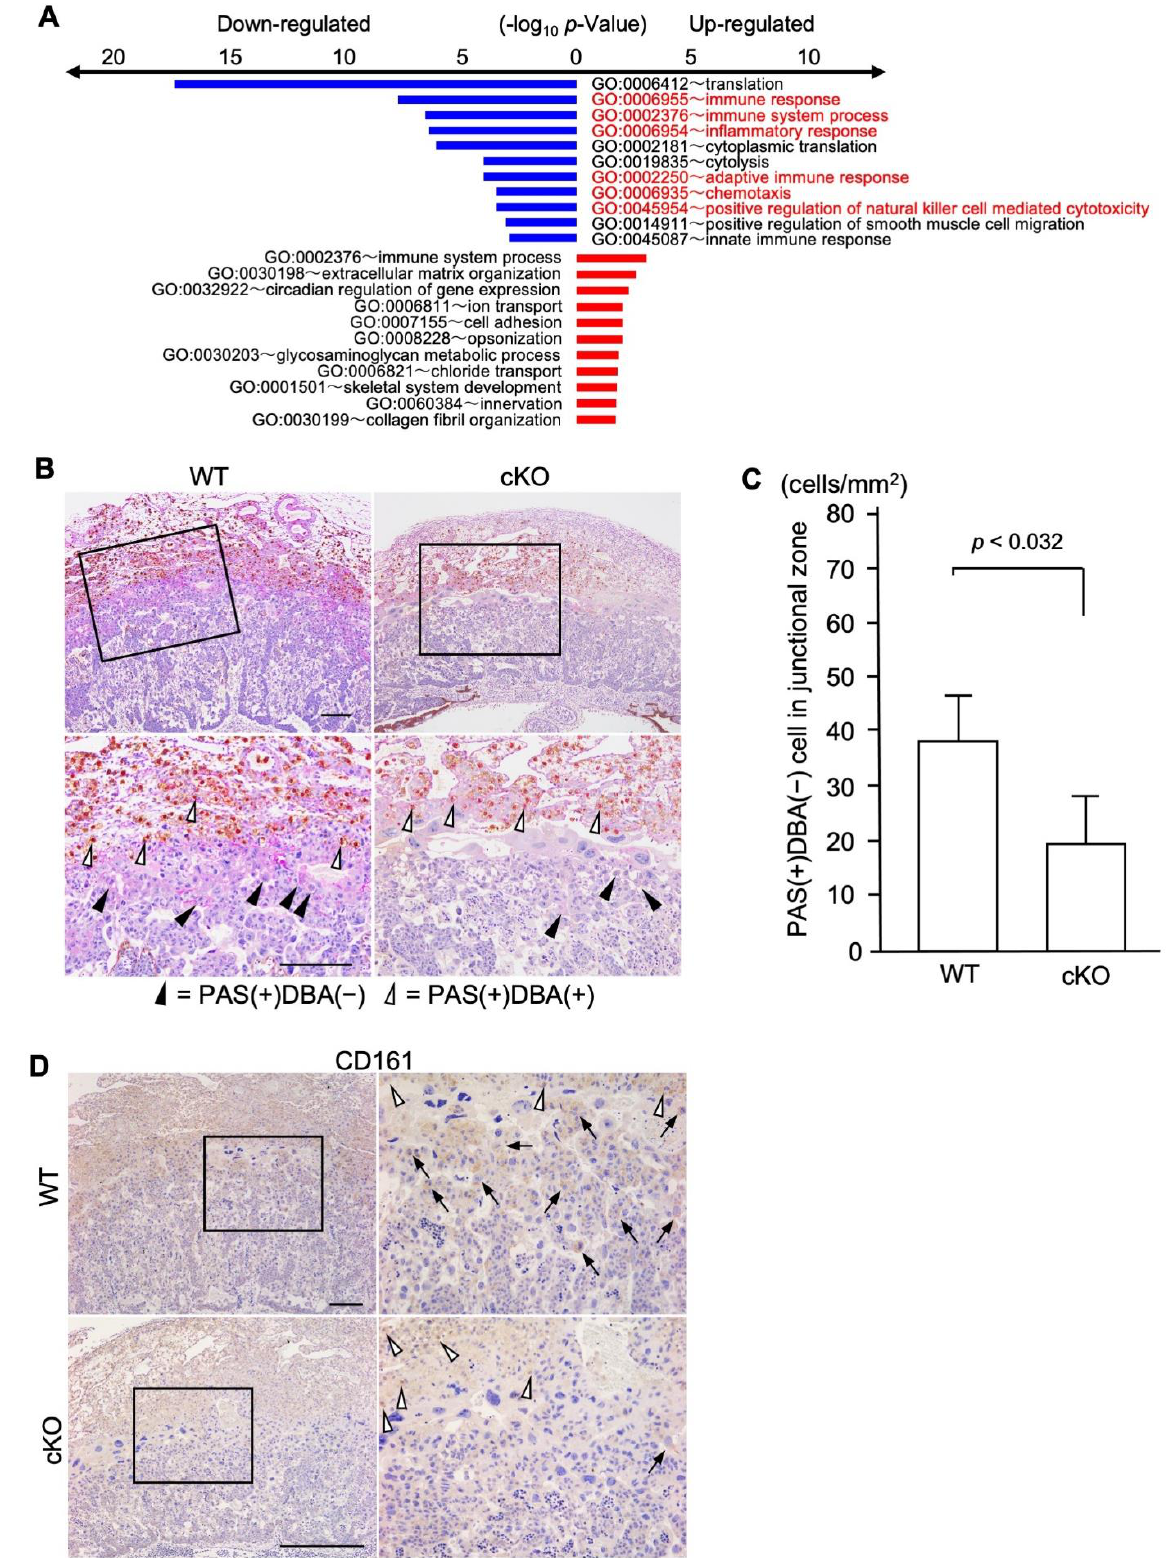
Figure 4. The immune environment in cKO uteri. ( A ) Gene ontology analysis with microarray data. The top 11 groups are shown. ( B ) DBA/PAS double staining with the placenta on day 12 of pregnancy. Black arrowheads show PAS-positive and DBA-negative cells. White arrowheads show both PAS- and DBA-positive cells. ( C ) In cKO mice, numbers of DBA-positive and -negative uNK cells were significantly lower than those in WT. ( D ) CD161 staining with the placenta on day 12 of